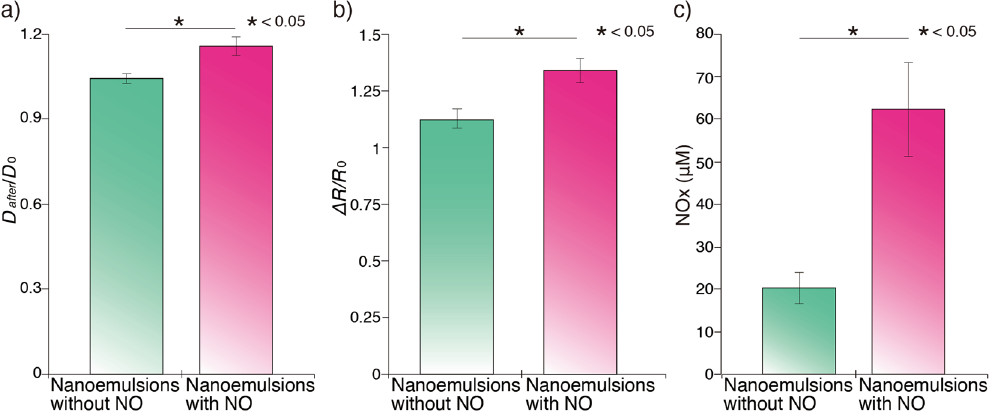
Figure 4. ( a ) Diameter of the penis after application of the NE with NO under anesthesia. The diameter of penis after application of the NE with NO increased significantly comparing with the control group treated with the oil without NO (D 0 : Diameter of penis without application of oil). ( b ) Redness value of the penis after application of the NE with NO under anesthesia. The redness value after application of the NE with NO was significantly higher than the control group (R 0 : Redness value of penis without application of oil). ( c ) Blood NOx concentration after application of the NE with NO. The level of blood NOx concentration increased 3-fold after the application of the NE with NO compared with control